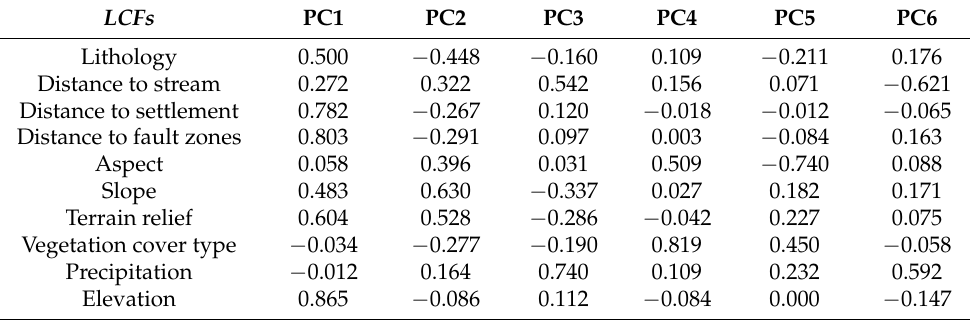
Table 2. Component matrix of LCFs .